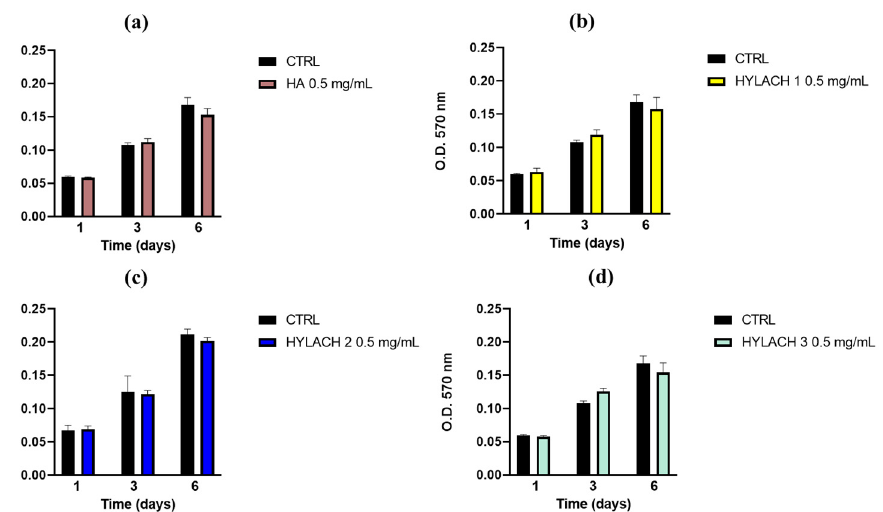
Figure 4. Time-dependent effects of HA and HYLACH on primary human bronchial fibroblast viability. Cells were seeded in 96-well culture dishes and exposed or not to HA ( a ), HYLACH 1 ( b ), HYLACH 2 ( c ), and HYLACH 3 ( d ) at the indicated concentration for various exposure times. The MTT test was performed 1, 3, and 6 days after treatment. Data are reported as mean ± SE of three independent experiments. Statistical differences based on unpaired Student’s t -test. Percentage of lactose-derived residues: HYLACH 1 = 10%, HYLACH 2 = 30%, HYLACH 3 = 40%.